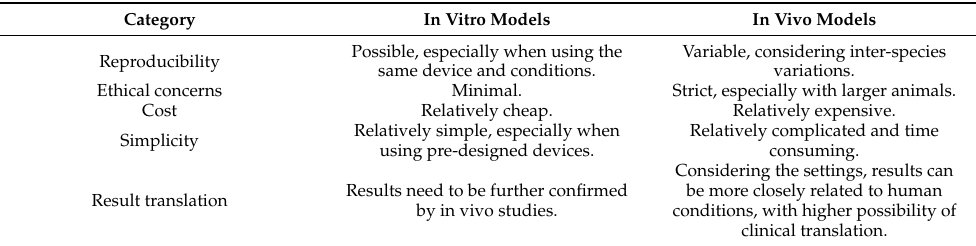
Table 3. A comparison between the advantages and disadvantages of in vitro and in vivo models in